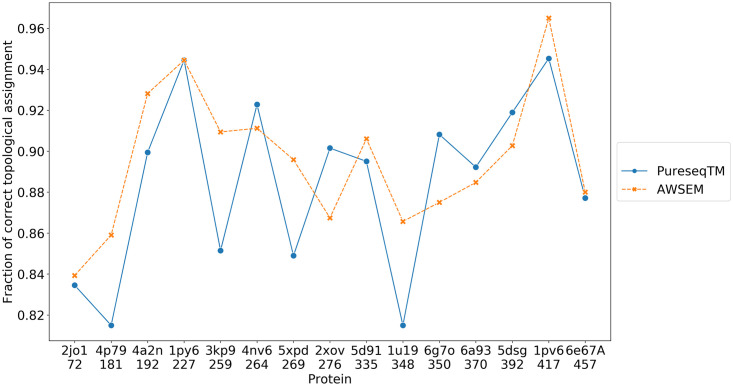
The fraction of correct location assignments of the residues relative to the membrane using a purely sequence-based method (PureseqTM) and that yielded by running OpenAWSEM simulations (AWSEM).